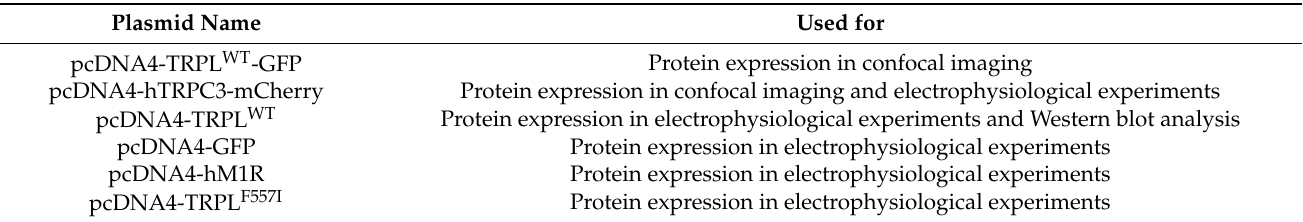
Table 1. Plasmids used in this